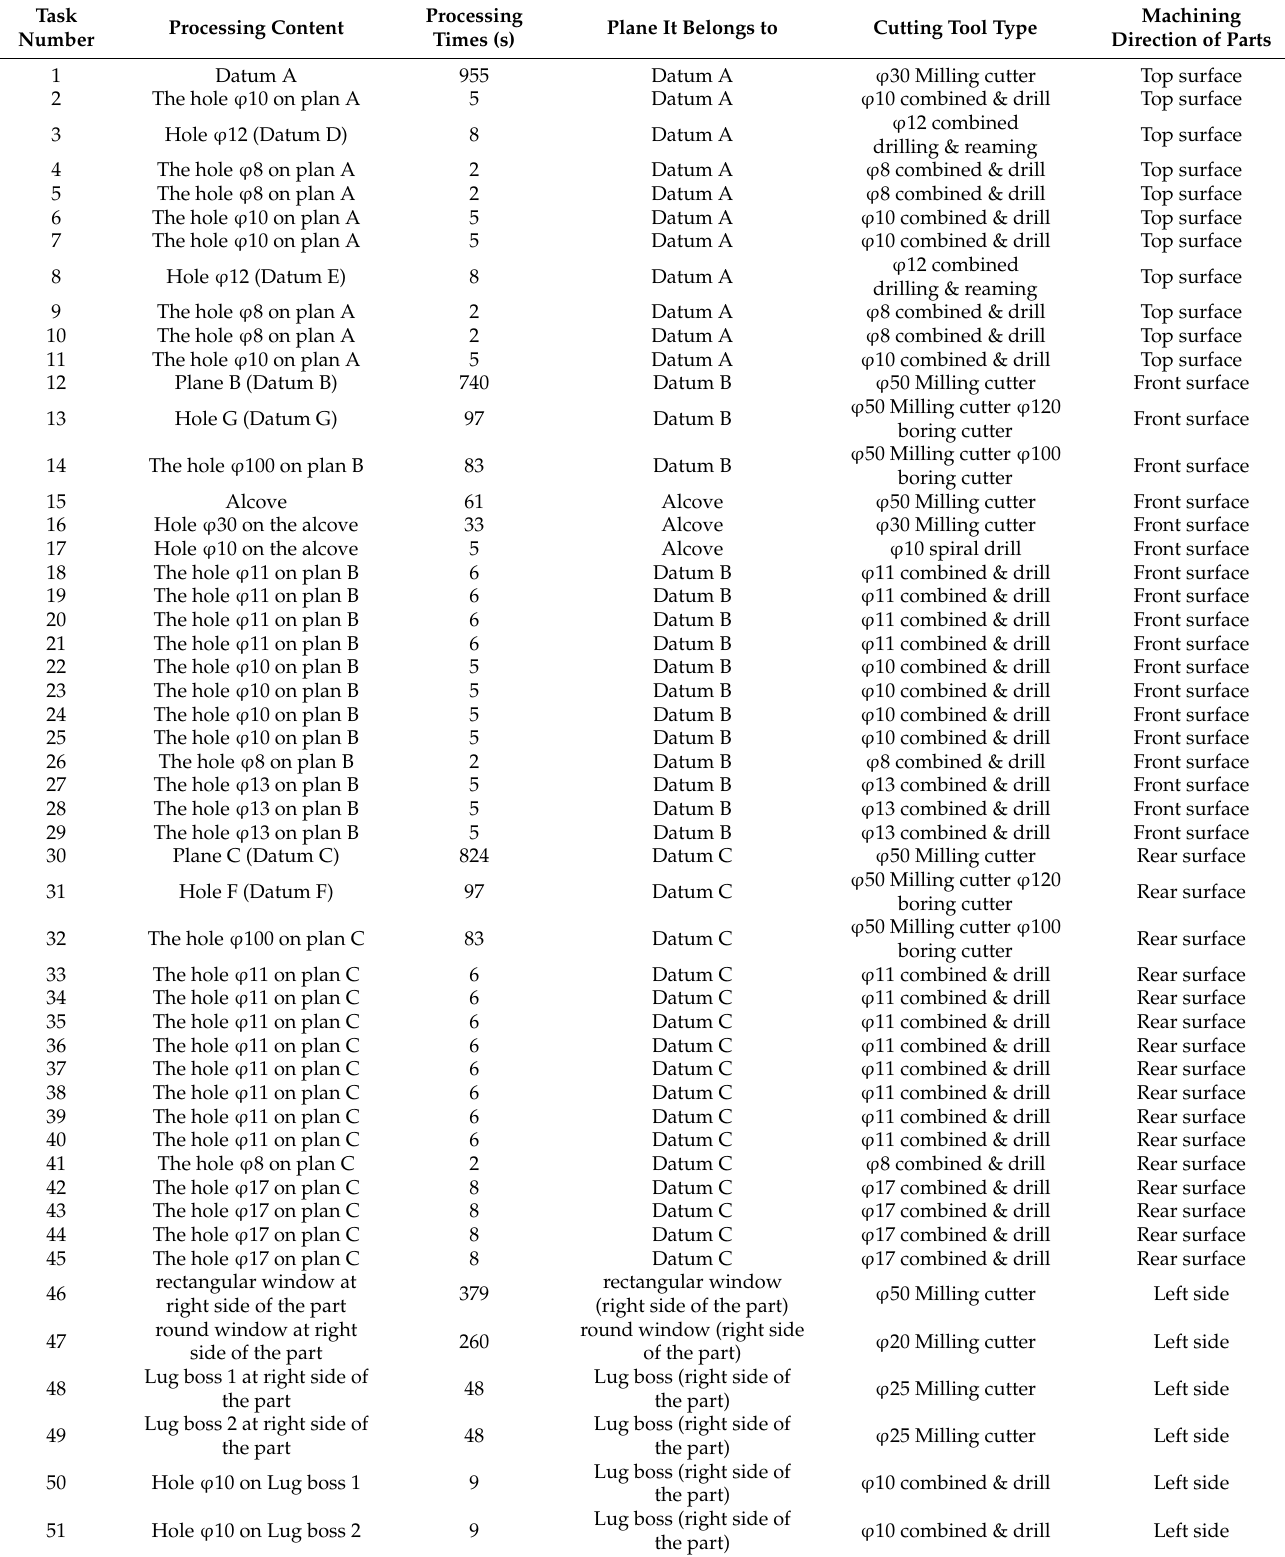
Table A1. Task operation procedure and